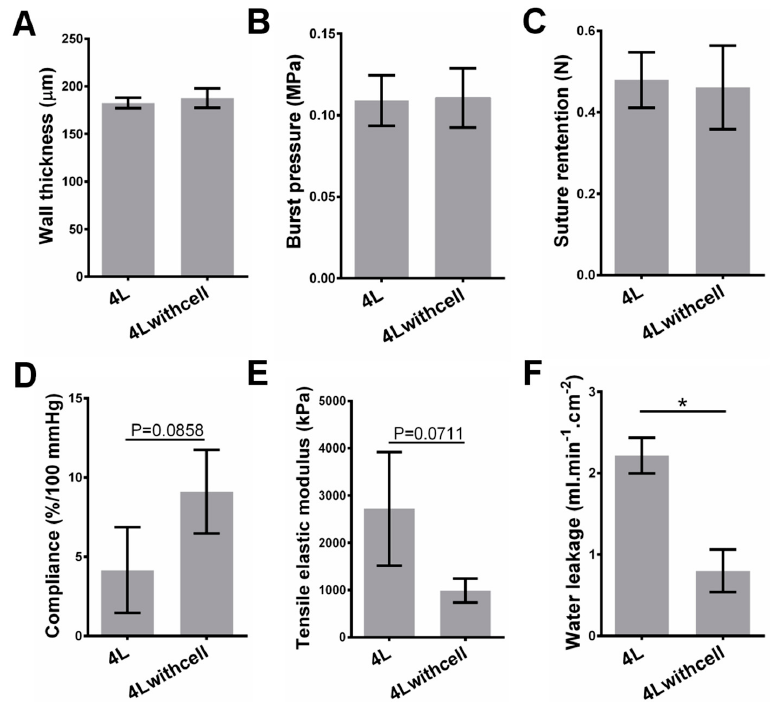
Figure 3. Comparison of mechanical properties of 4 layered scaffolds with and without cells. Wall thickness ( A ), burst pressure ( B ), suture retention ( C ), compliance ( D ), tensile elastic modulus ( E ), and water leakage ( F ). All tests were biological triplicates. * indicates the p value smaller than 0.05.